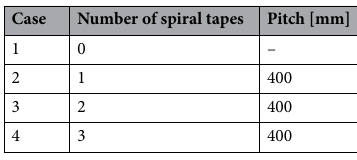
Table 1. The geometric